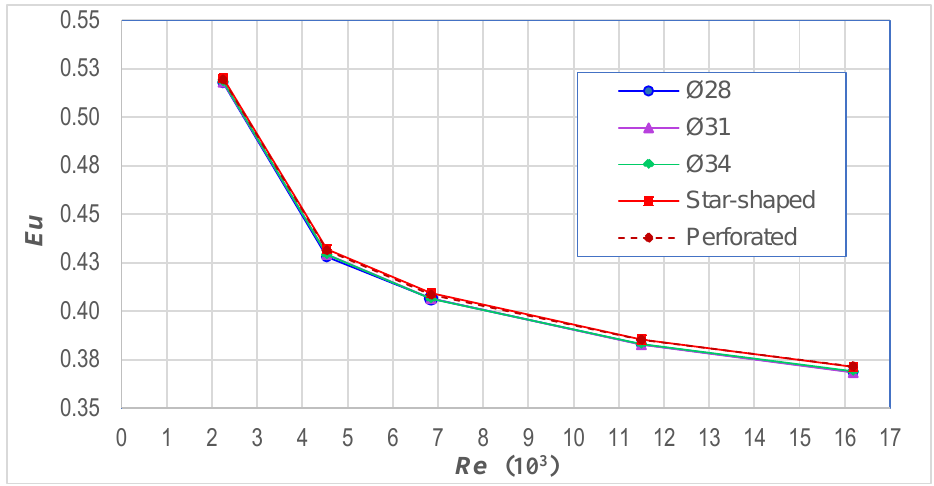
Figure 16. Euler number versus Re number.